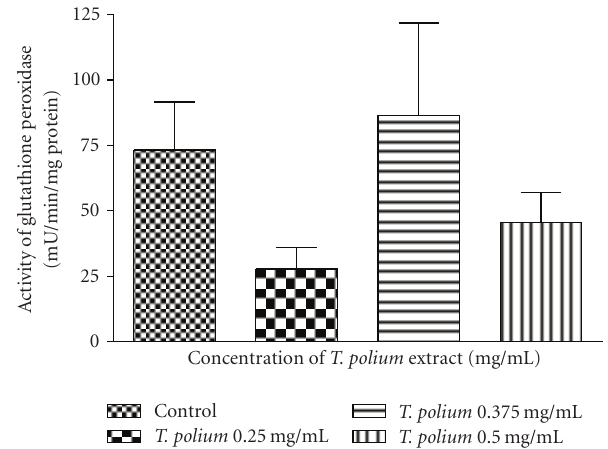
Figure 5: E ff ect of a 24-hour exposure of an aqueous extract of T. polium on glutathione peroxidase activity in HepG2 cultured cells. Data are presented as mean ± standard deviation. Sample size ( n ) = 10.